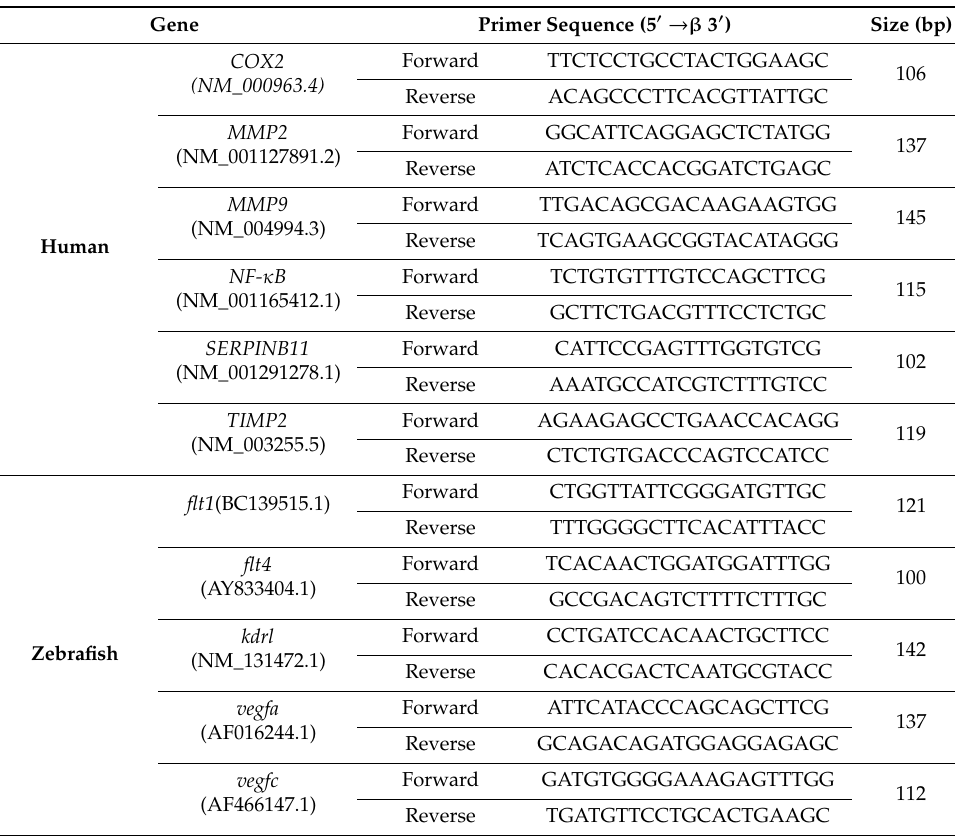
Table 2. Primer information for quantitative